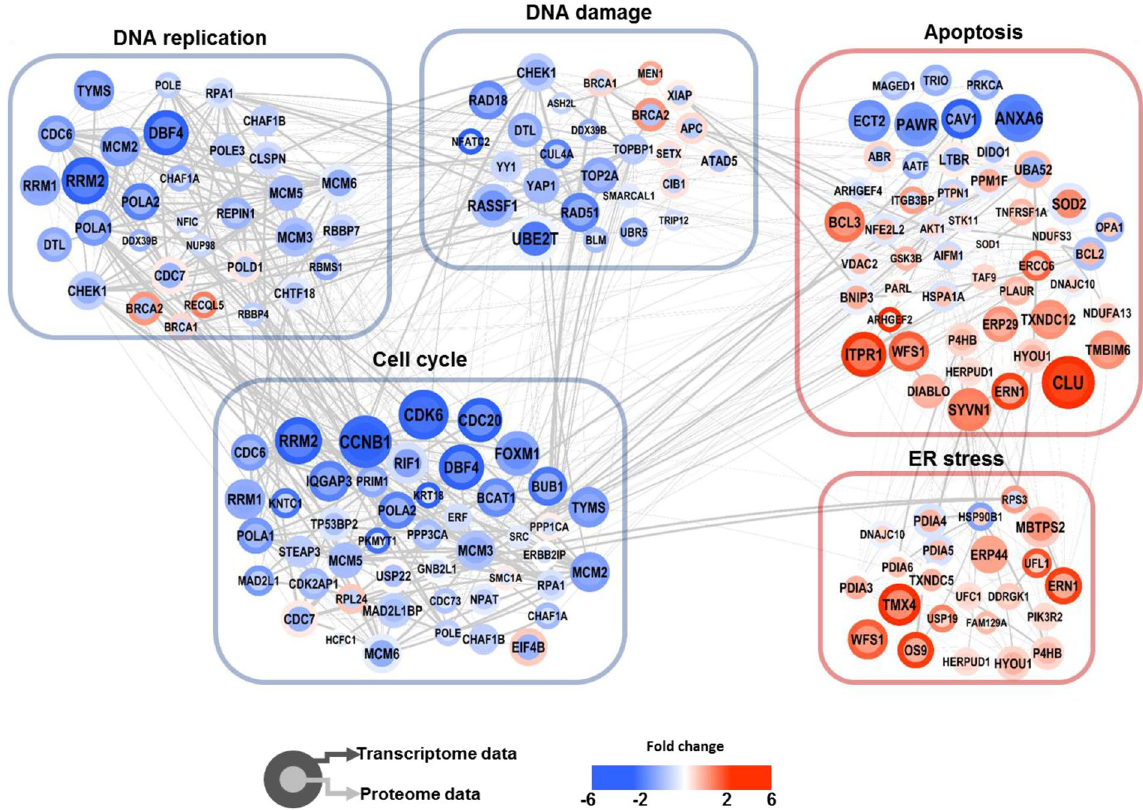
Figure 3. Overview of the interaction network model. The overall organization of the protein-protein interaction was visualized using Cytoscape 3.4.0. Colors of the border and inside nodes indicate the expression levels of quantified proteins and mRNAs, respectively. Gray edge line thickness defines the protein-protein interaction score identified in the STRING public database. Blue and pink boxes are clustered proteins, which are significantly enriched gene ontology biological process terms derived from the DAVID functional annotation classification tool with P -values < 0.05 classified as significant using a modified Fisher’s exact